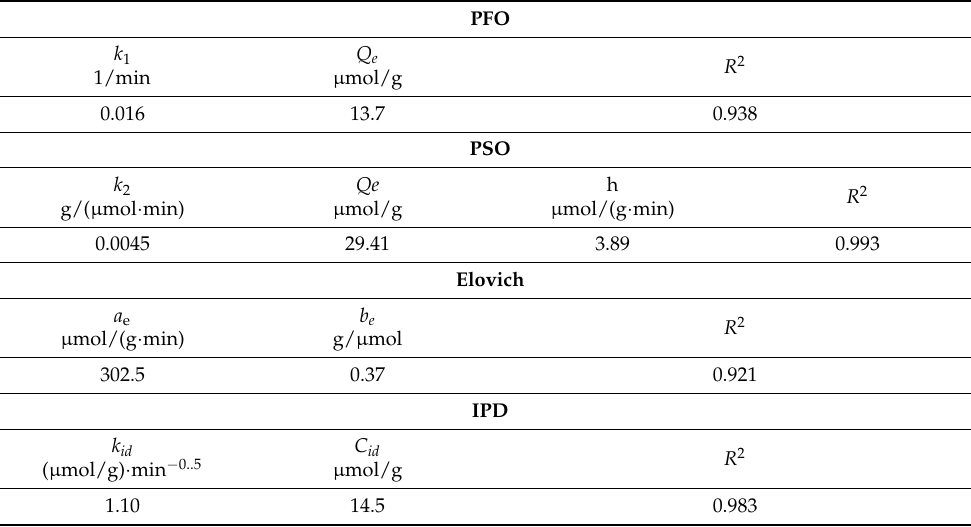
Figure 9. ( a ) PFO, ( b ) PSO, ( c ) Elovich and ( d ) IPD kinetic plots for V(V) sorption on solutions onto m-Si-poly(GME)-deta. Table 4. PFO, PSO, Elovich and IPD kinetic parameters V(V) ion sorption using